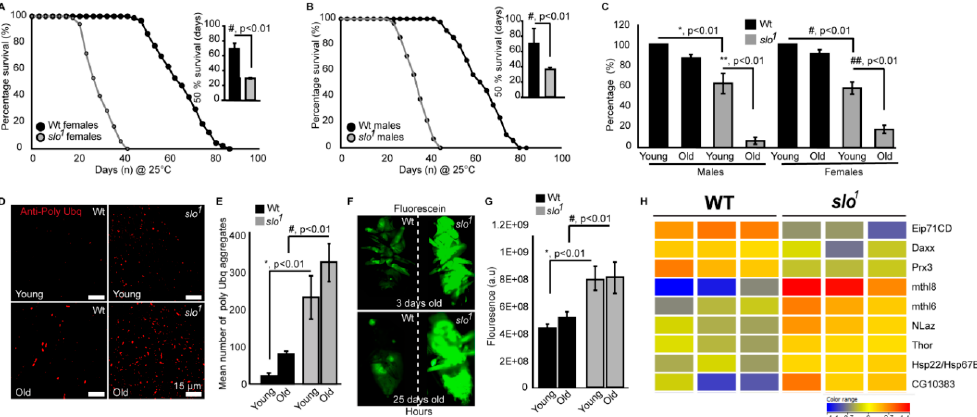
Figure 5. slo 1 mutants reveal accelerated aging. Drosophila BK Ca ( slo 1 ) mutants show significantly reduced lifespan of females ( A ) and males ( B ) by approximately 50% compared to wild ‐ type (wt) flies. The inset shows 50% survival for wt (black) and slo 1 (gray), which was reduced significantly for slo 1 mutants. ( C ) Negative geotaxis assay for wt and slo flies at young (day 3) and older flies (day 30) shows reduced ability of slo 1 mutants to climb the marked distance in a given time in vials compared to their controls. ( D ) Increased polyubiquitination staining is observed in slo 1 mutants (red) as compared to wt in both young and older ages and quantification is provided in ( E ). ( F ) slo 1 mutants show increased intestinal perforations as determined by the leakage of fluorescein dye (green) from the gut unlike control flies, which only show the dye in their gut at both young and older ages. ( G ) Quantification of fluorescein signal from ( F ). ( H ) Microarray data showing differential expression of life span ‐ related genes in wt and slo 1 mutants.